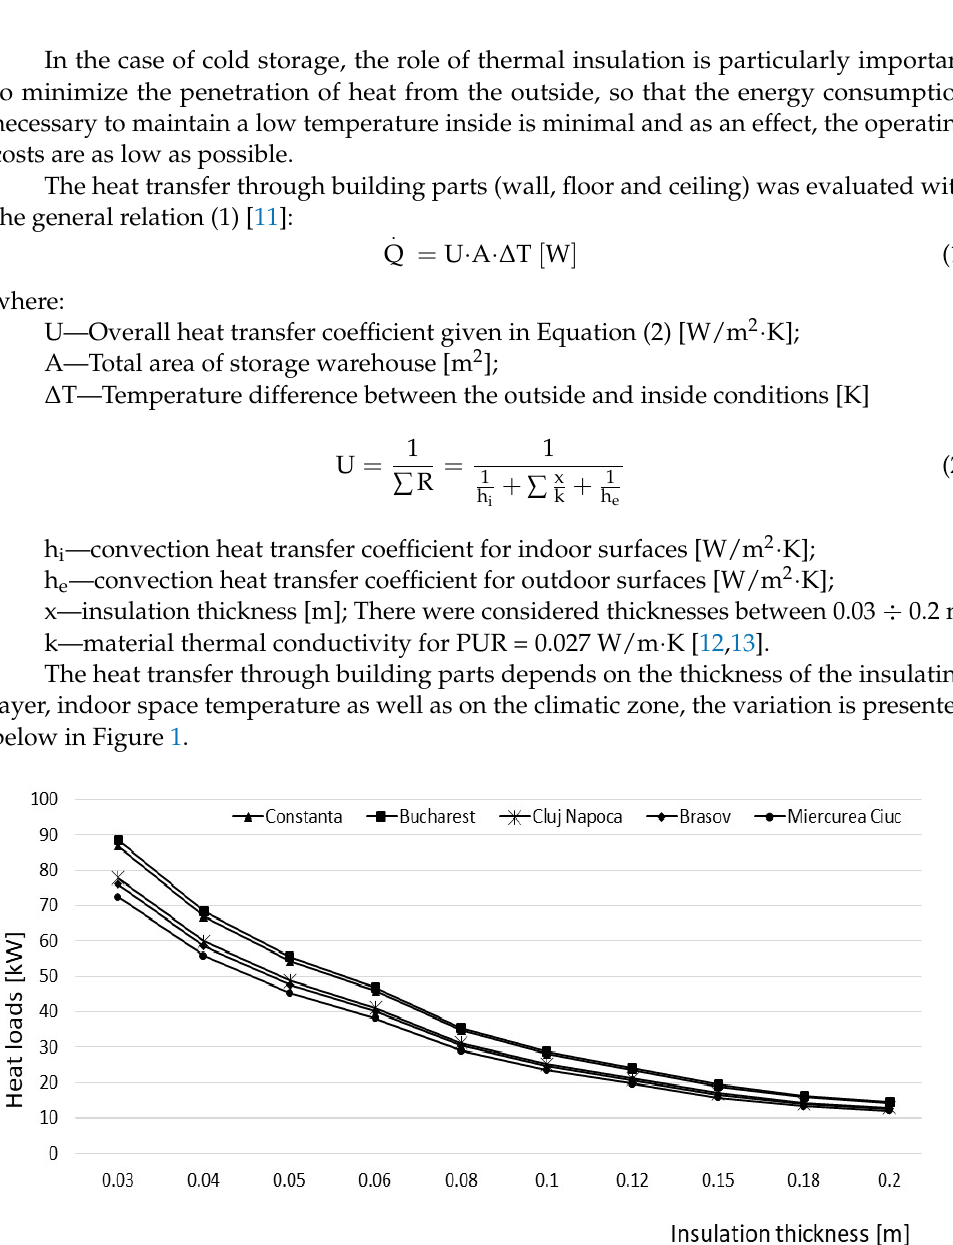
Table 2. Outdoor temperature.